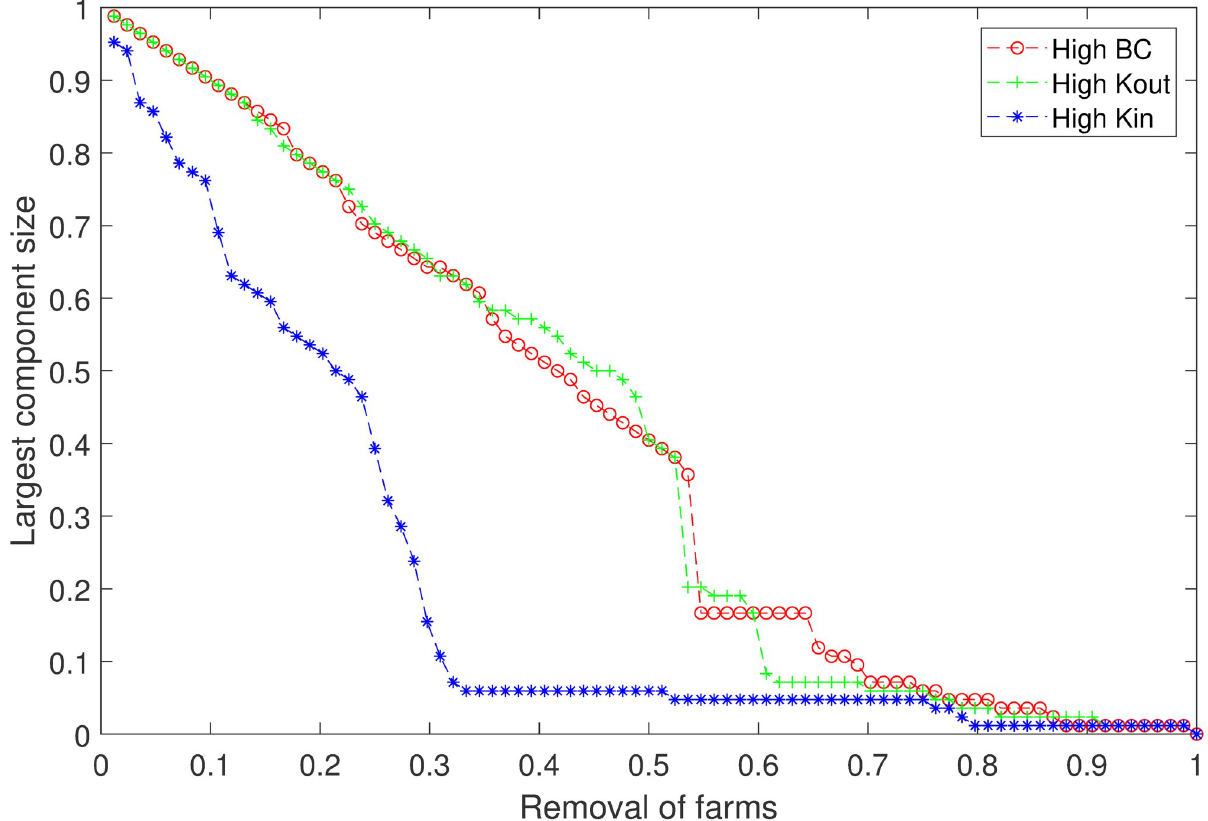
Fig 3. Network robustness analysis by the gradual removal/isolation of farm nodes. The farm nodes are removed in a decreasing order of different centrality measures and the size of the largest weakly connected component (at the farm-level) is plotted. Both of the axes are plotted as fractions of total farms in the network. For the removal of nodes, they are separately ranked with three independent centrality measures: high betweenness centrality ( BC ), high out-degree centrality ( K out ), and high in-degree centrality ( K in ).